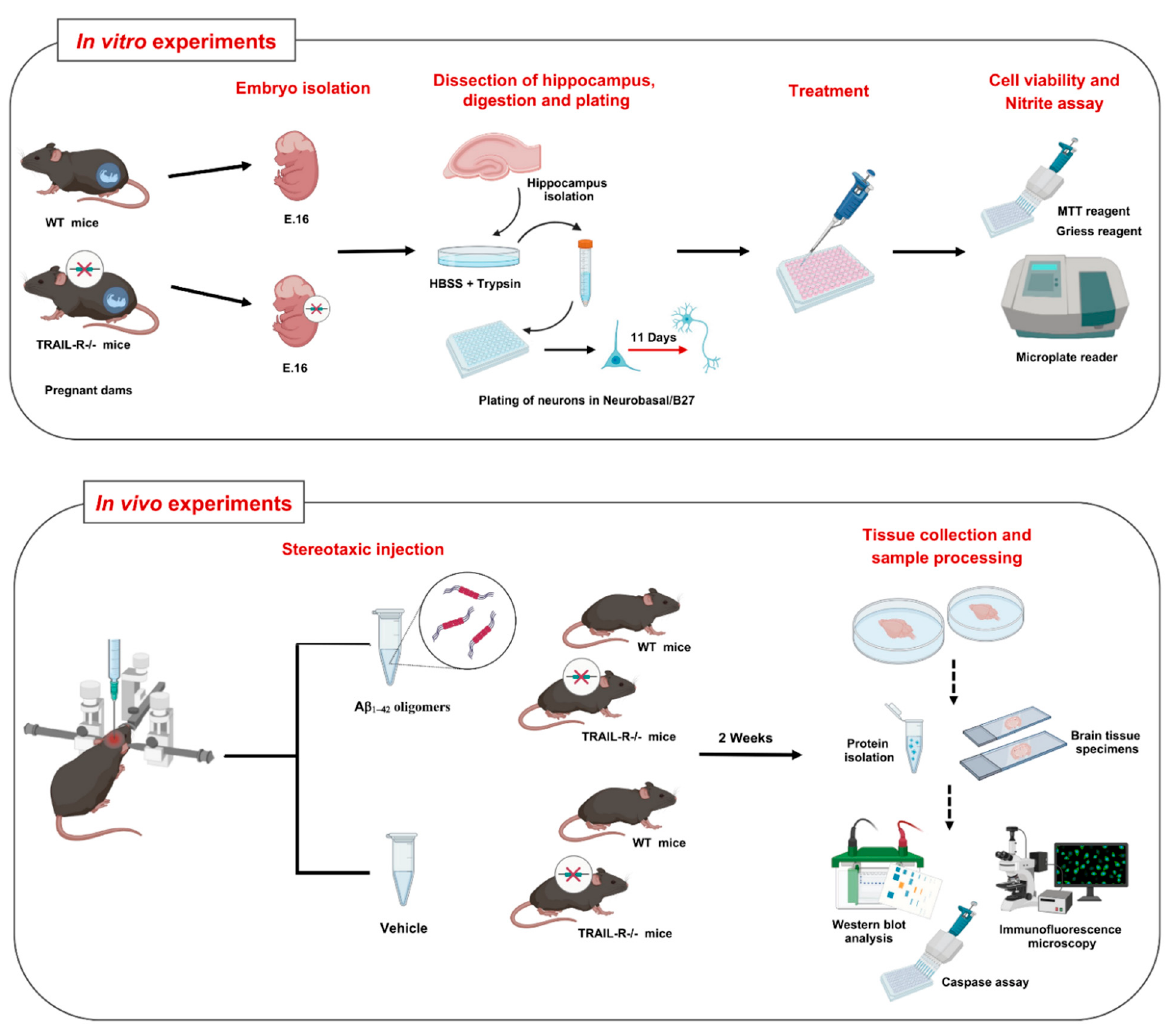
Figure 1. Experimental design for in vitro and in vivo experiments. Upper panel: Schematic representation of the main steps for the preparation of primary cultures of embryonic hippocampal cells derived from wild-type (WT) and TRAIL-R − / − mice, including embryo isolation (16 embryonic day E.16), hippocampal dissection, enzymatic/mechanical digestion, plating of neurons and differentiation for 11 days. Differentiated neurons were treated with various compounds. After that, cell viability and nitrite assay were performed. Lower panel: The scheme summarizes the experimental design for in vivo experiments. Wild type (WT) and TRAIL-R − / − mice were stereotaxically injected with A β 1-42 oligomers and vehicle. After 2 weeks, animals were sacrificed, and tissues were collected to perform protein analysis using several techniques.